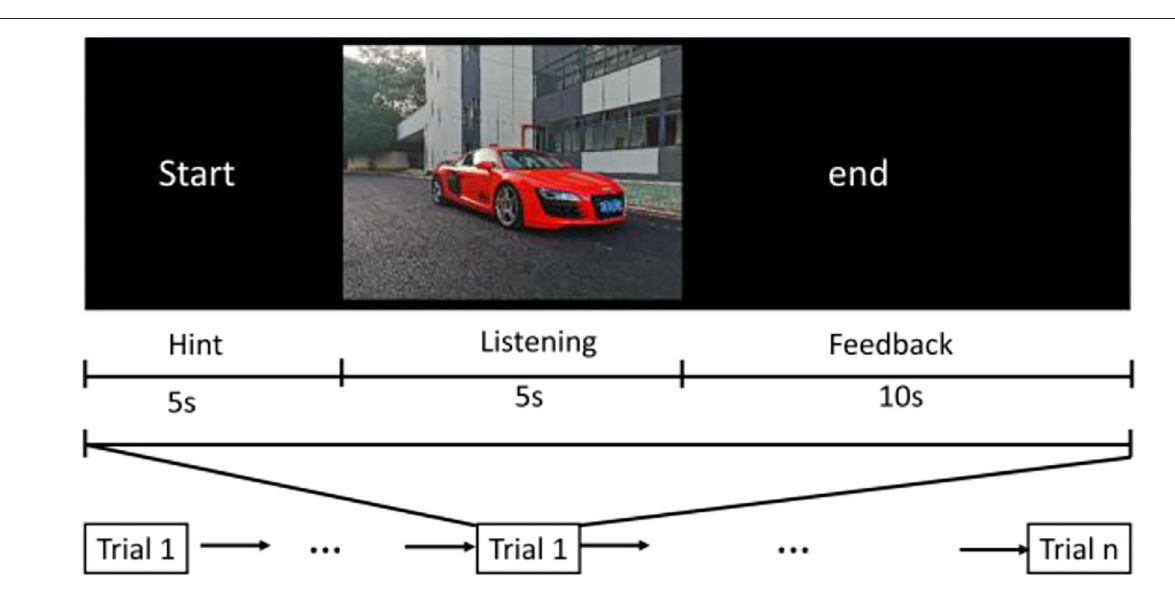
FIGURE 3 | The protocol used in the experiment for sound quality evaluation.